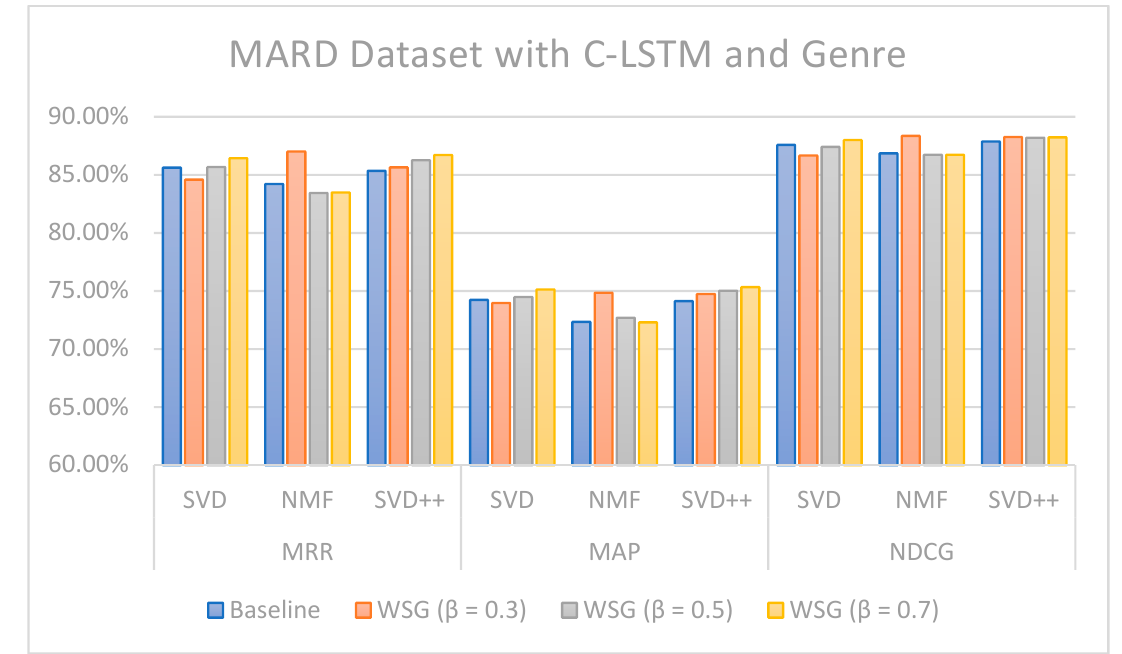
Figure 5. MRR, MAP, and NDCG values without and with C-LSTM sentiment and genres-based model on the MARD dataset with different 𝛽 values. Table 3. MRR, MAP, and NDCG values (%) without and with L-CNN sentiment and genres-based model on Amazon Movie dataset with different 𝛽 values.